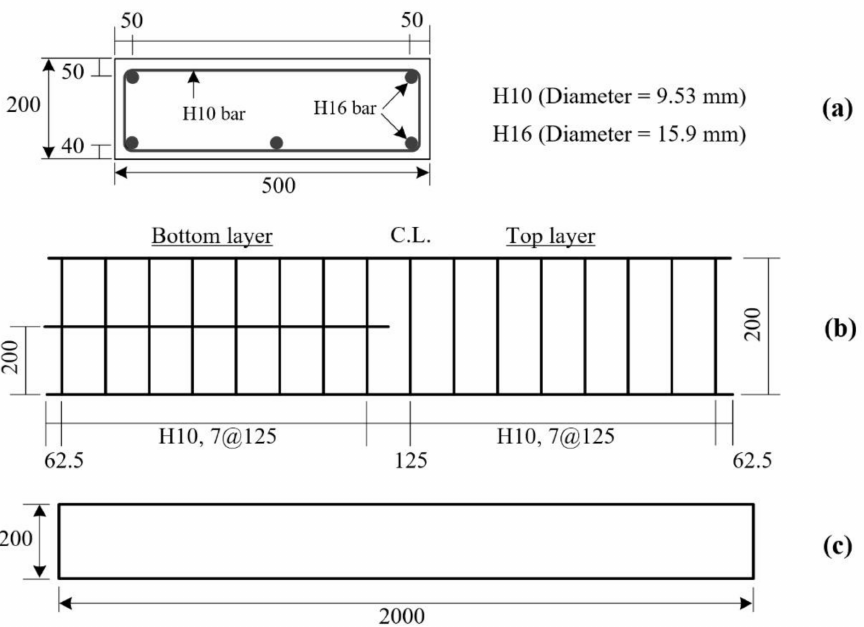
Figure 6. RC slab: ( a ) cross-sectional dimensions; ( b ) reinforcement details; ( c ) side view (unit: